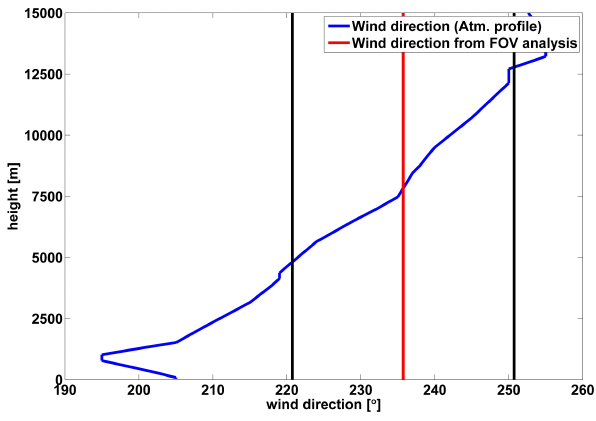
Fig. 10. Wind direction profile as measured by a radiosonde. The calculated wind direction in the cloud layer is 236 ◦ ± 15 ◦